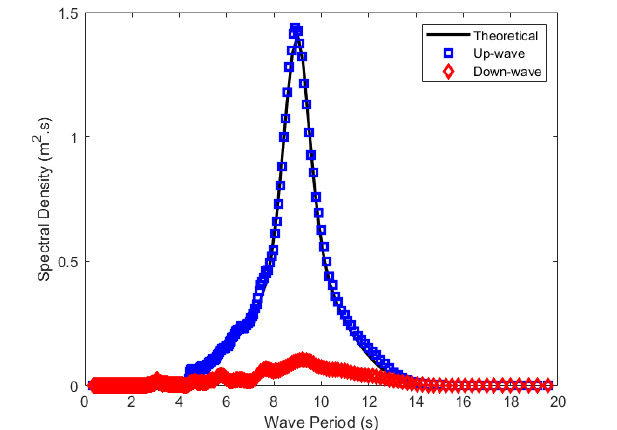
Fig. 4: Comparison of wave spectra at up-wave and down-wave locations with a theoretical JONSWAP wave spectrum at a significant wave period of 9s. Fig. 4 shows wave spectra for an irregular wave cancellation simulation at a significant wave period of